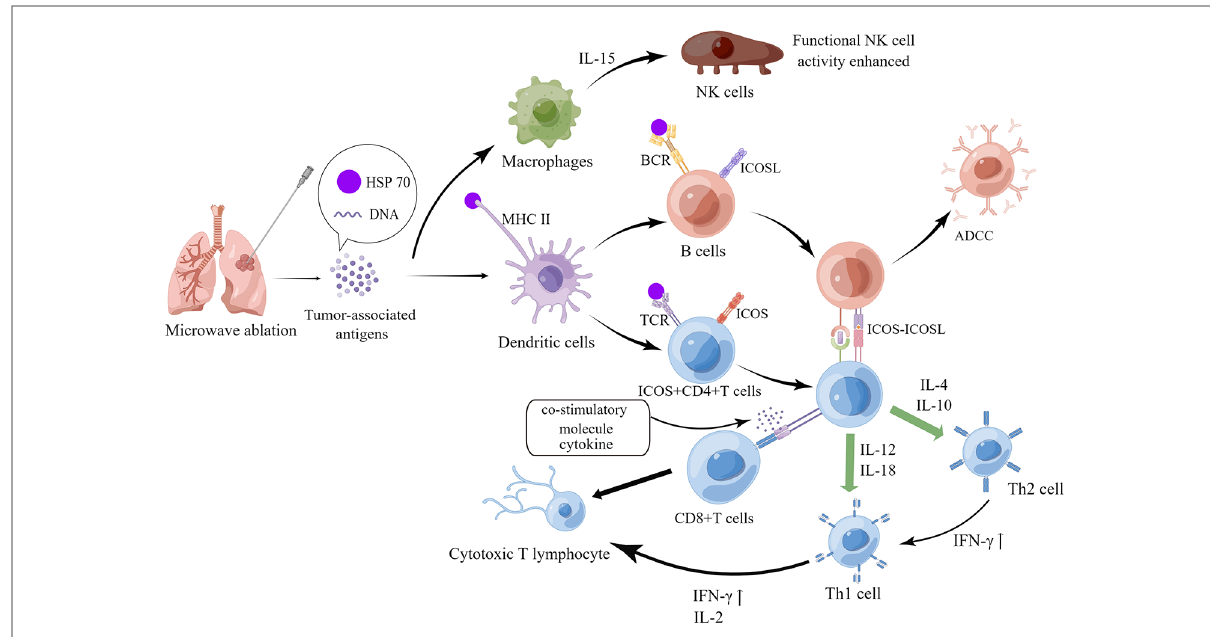
FIGURE 4 Mechanism of systemic anti-tumor immune response induced by microwave ablation. The fi gure was drawn by